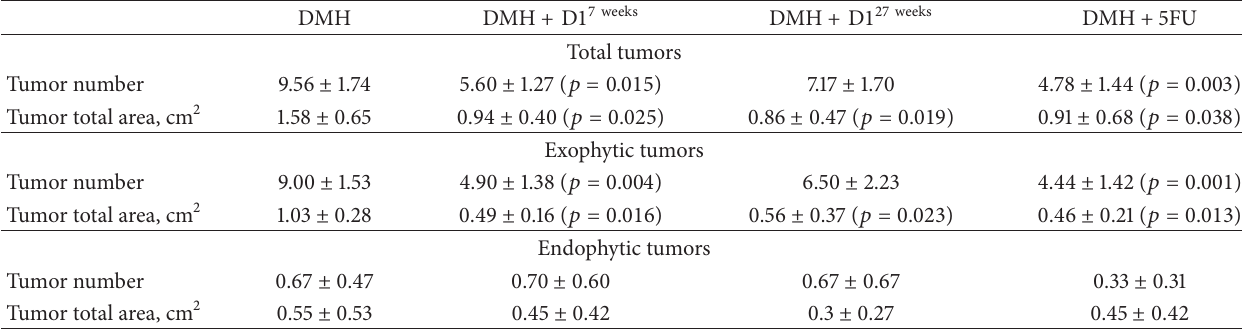
Table 1: Tumor parameters for rats treated by D1 and 5FU under DMH-induced carcinogenesis. Mean ± SEM, 𝑛 = 10 # .